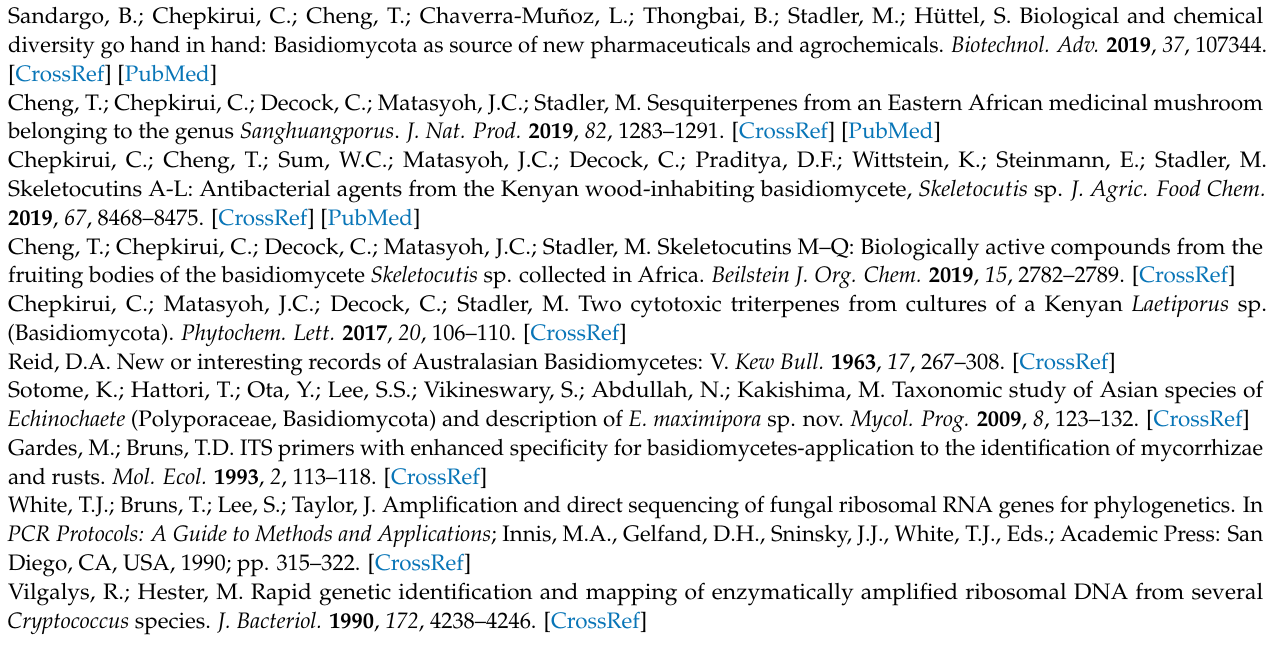
Figure S21: ESIMS data for compound 4; Figure S22: 1H NMR spectrum (acetone-d4, 500 MHz) of (4); Figure S23: 13 C spectrum (acetone-d4, 13 C 125) of (4); Figure S24: HSQC spectrum in acetone-d4 (1H 500 MHz, 13 C 125) of (4); Figure S25: HMBC spectrum in acetone-d6 ( 1 H 500 MHz, 13 C 125 MHz) of (4); Figure S26: ROESY spectrum in acetone-d6 ( 1 H 500 MHz) of (4); Figure S27: Phylogeny of Echinochaete , based on LSU and